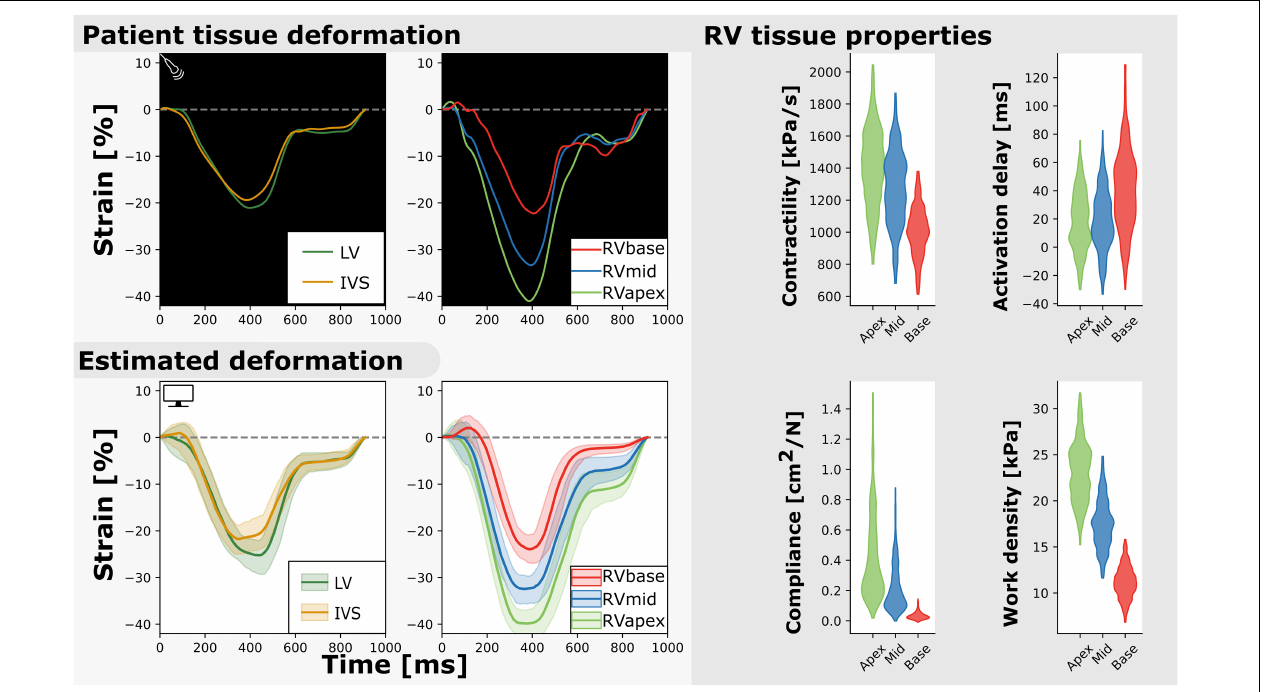
FIGURE 3 | Measured and estimated strain of real subject (left) and violin plots of estimated parameters (right). Deformation patterns and regional heterogeneity was well captured by the model. The best simulation in the sample set was in good agreement with to the patients dataset ( X 2 o pt = 8 . 9 )